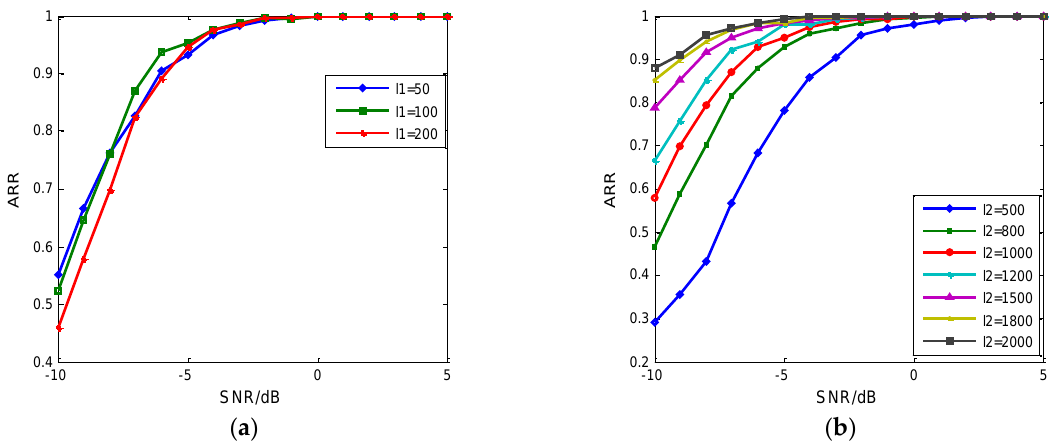
Figure 14. The influence of sample length on ARR. ( a ) The influence of input feature vector’s length on the ARR; ( b ) The influence of time domain signal’s length on ARR.